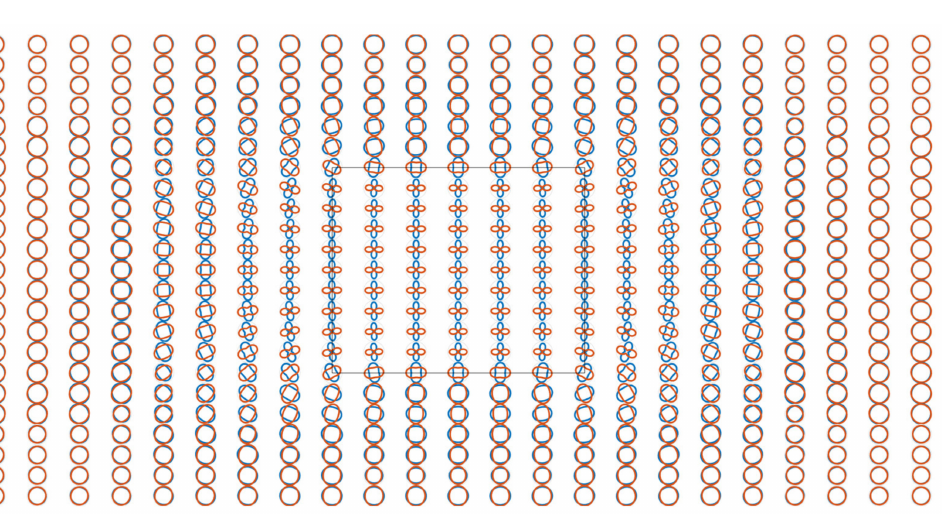
Figure 7. Polar plots of COMMEMI 3D-1A model for a frequency of 0.57 Hz. The distances between the origin of coordinates and points on the curve represent the magnitude of apparent resistivity, and the radial directions indicate the observed directions of polarized electric fields. The red apparent resistivity ( ρ a ϕ r ) curves defined by the azimuthal electric and radial magnetic fields are orthogonal to the blue apparent resistivities ( ρ a r ϕ ) curves defined by radial electric and azimuthal magnetic fields and appear as an anisotropy paradox [9]. The red and blue curves with respect to polar plots adhere to the same definition in this figure. All pairs of polar plots are located at sites shown in Figure 5. The 0 ◦ azimuth was at the top of the polar plots and rotated clockwise, axis and tick labels were omitted due to the dense layouts of polar plots. The rectangle is the projection of the anomalous prism on the earth’s surface, but it is not consistent with the original scale.